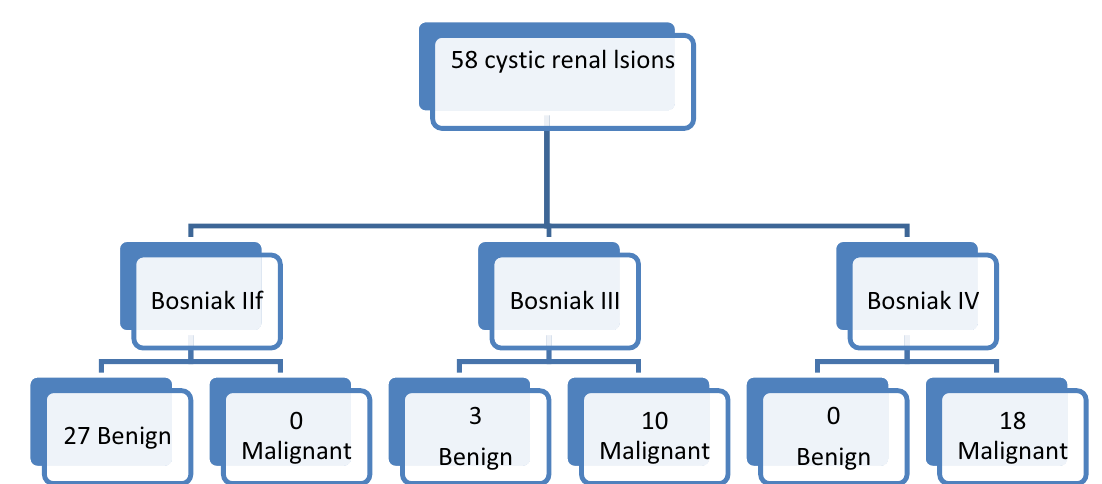
Fig. 2 Flowchart of Bosniak classification of cystic renal masses by multiparametric MRI & outcome of the 58 included cystic renal lesions